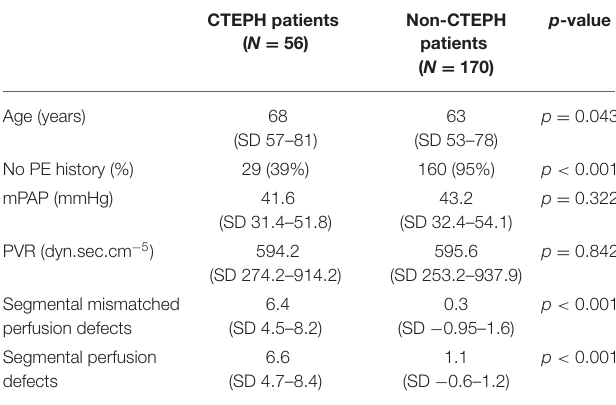
TABLE 1 | Patient baseline